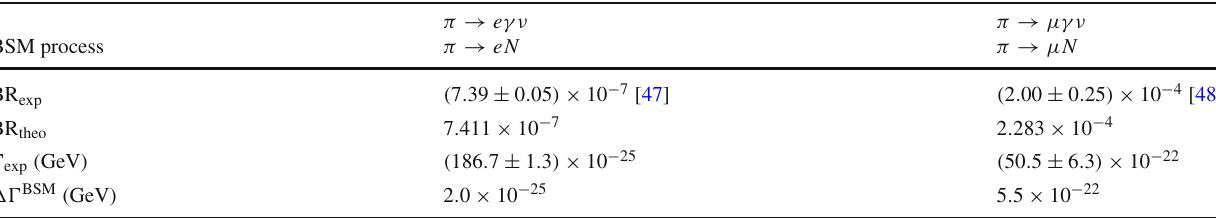
Table 5 Measured values and theoretical predictions of branching ratios for different π decays. The theory predictions are taken from the corresponding experimental references. For convenience, we also